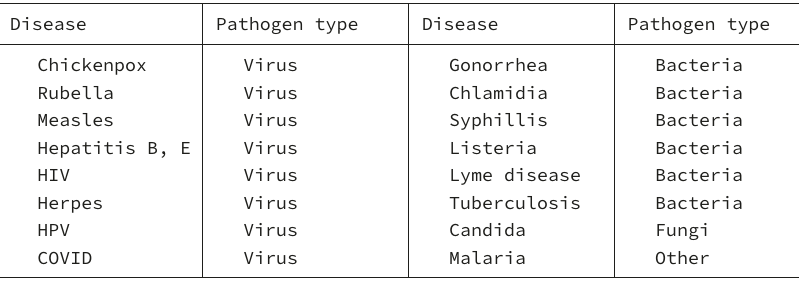
Fig. 2 | Examples of vertically transmitted diseases. Here we provide a non-exhaustive list of pathogens that are vertically